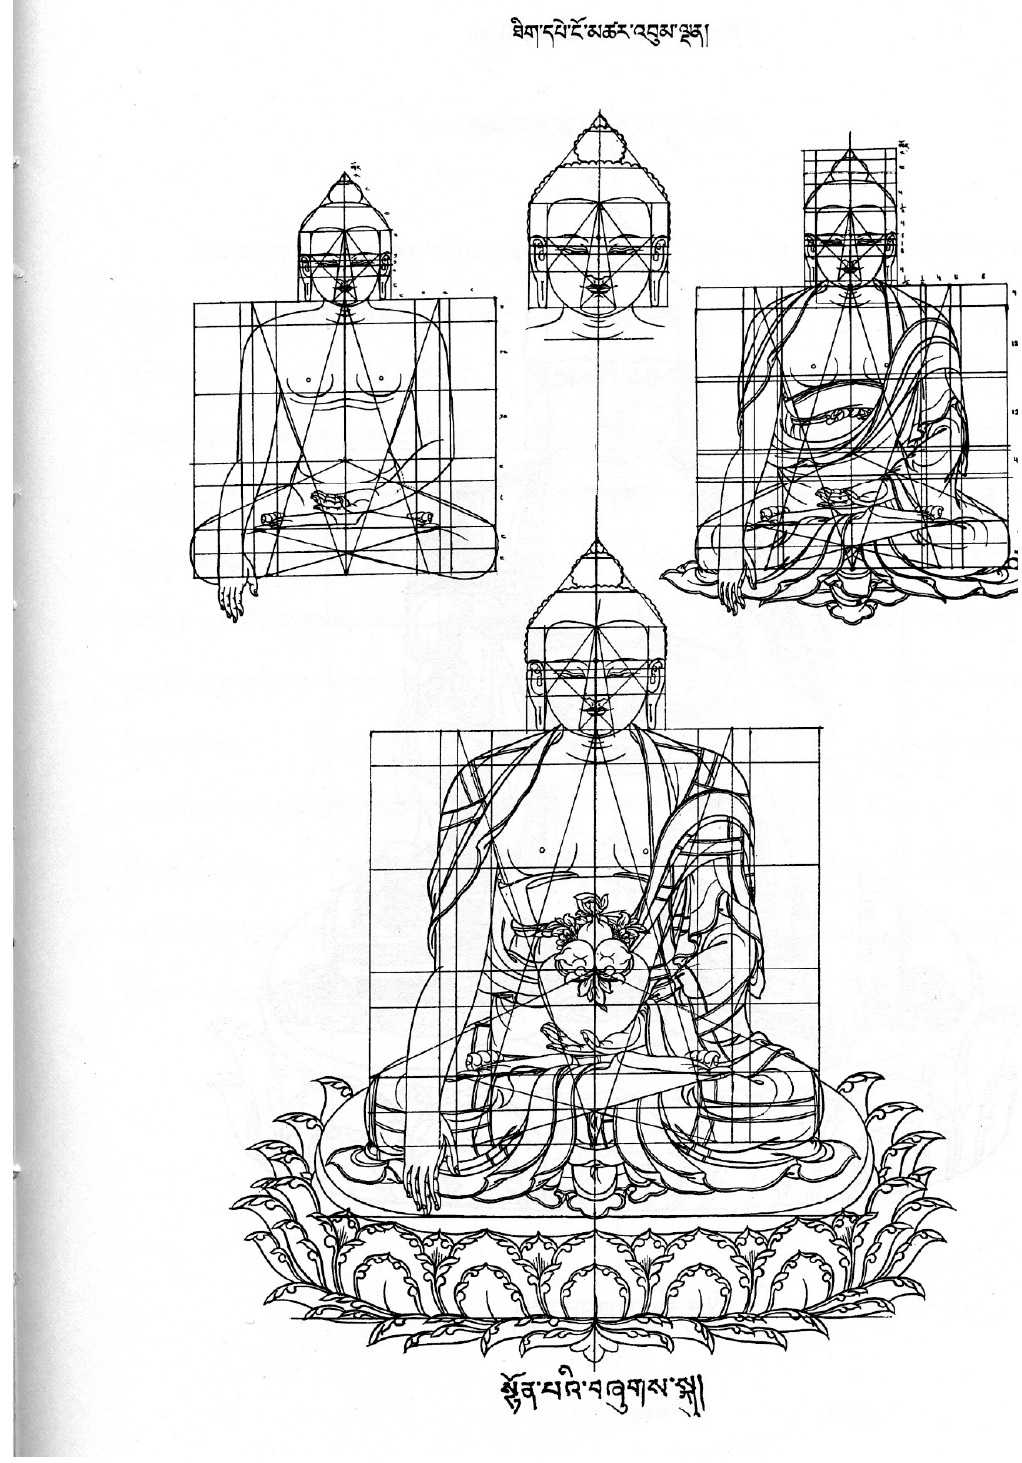
Figure 6. Page of an Iconometry Manual designed by the renowned Ladakhi painter Tsering Wangdus (tshe ring dbang ’dus) (Photo C. Bellini 2011).